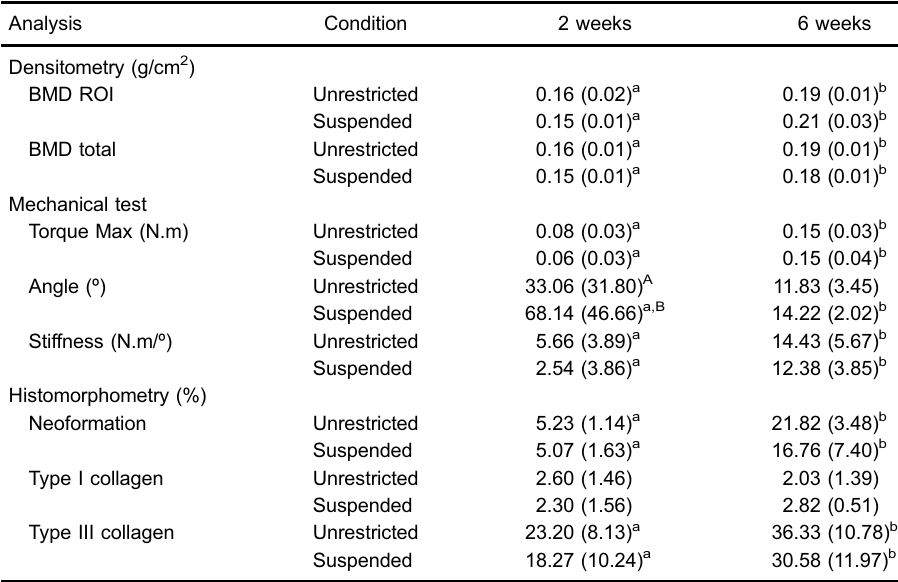
Table 2. Analyses at the osteotomy site of the right